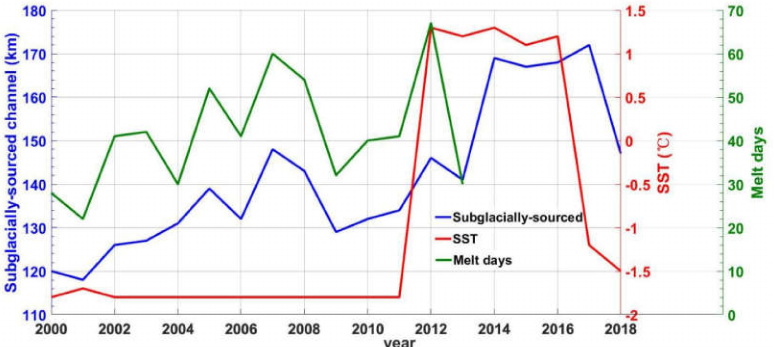
Figure 16. The time series of subglacially-sourced channel, SST and ice sheet surface melting